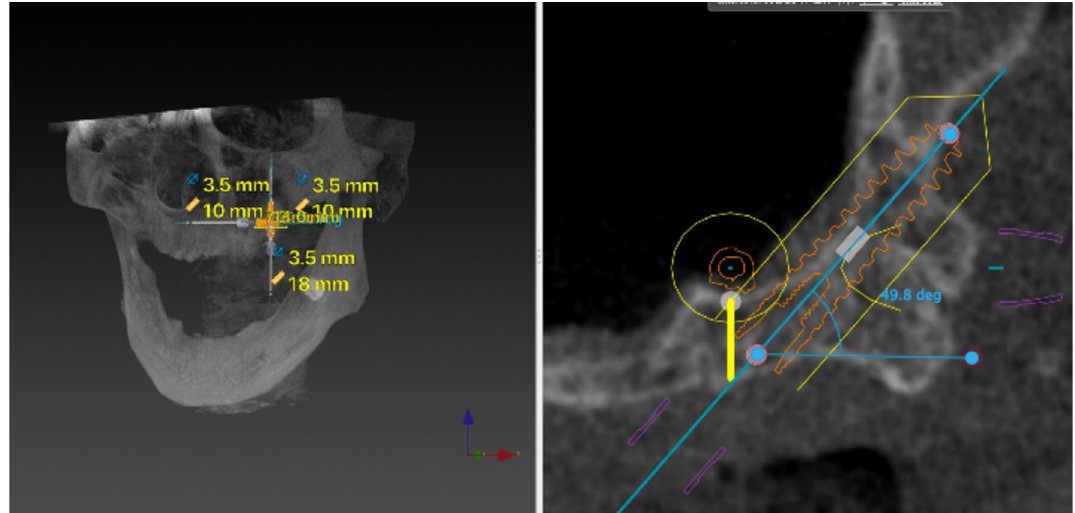
Fig. 7 Maintain the inclination of the implant and adjust the implant apical exit point to penetrate the most concave cortical layer of the pterygoid